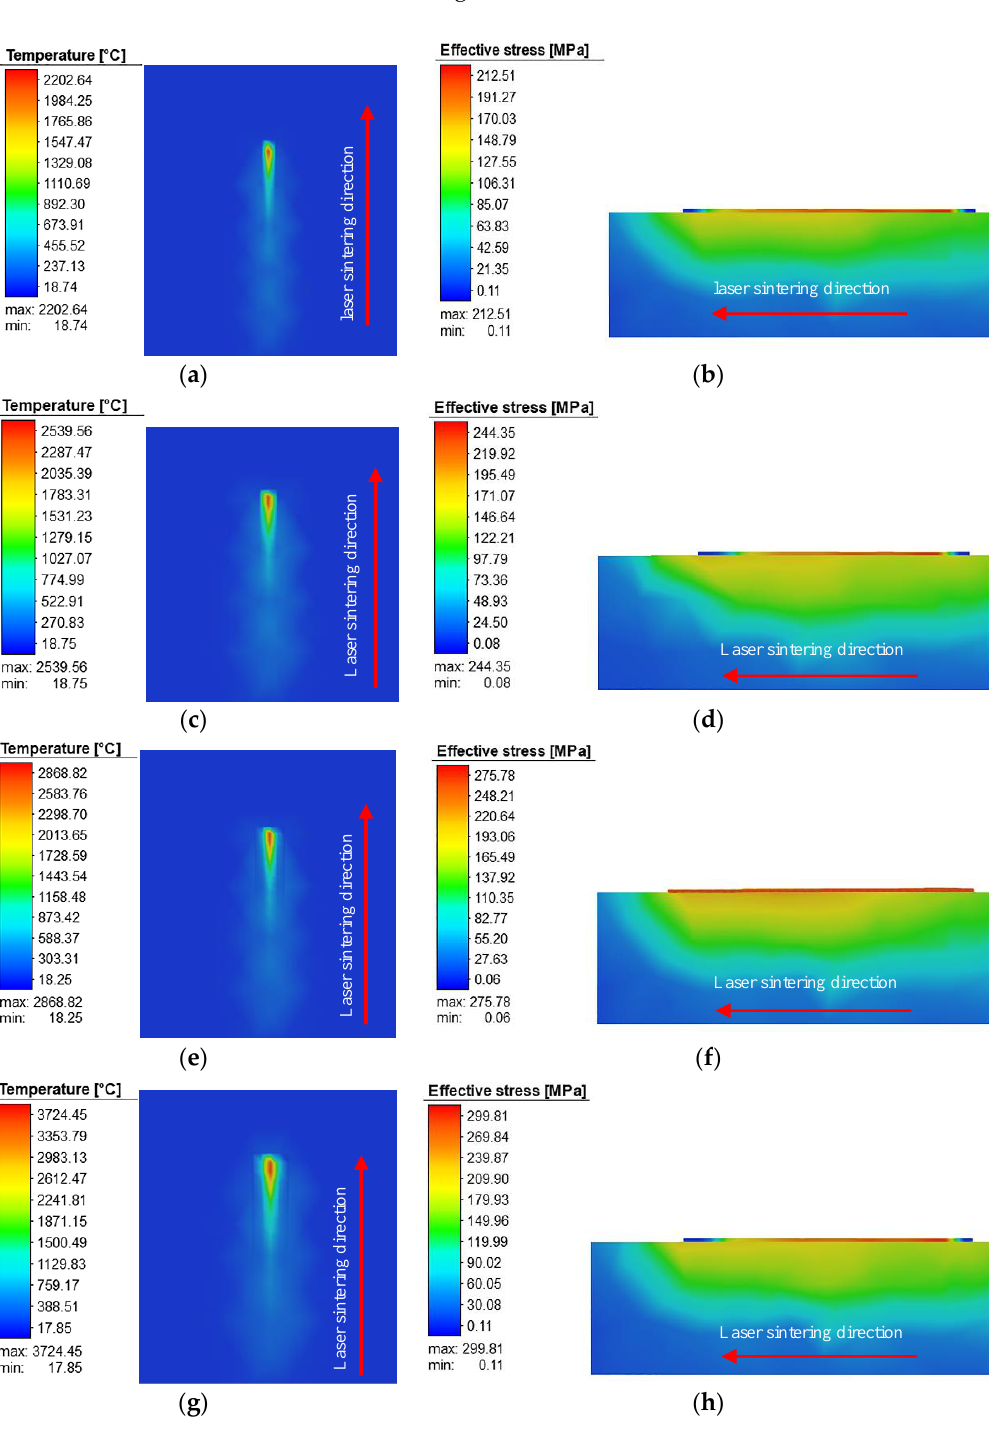
Figure 7. Temperature and stress fields in the melt pool for different energy densities: ( a , b ) ω = 41.7 J/mm 3 , ( c , d ) ω = 67.7 J/mm 3 , ( e , f ) ω = 77.4 J/mm 3 , and ( g , h ) ω = 111.1 J/mm 3 . From the temperature field (a), (c), (e), and (g) plots in Figure 7, it is seen that the laser shows a predominantly comet-like path during processing, with a significantly higher temperature gradient in front of the heat source than at the tail. The most important factor influencing the difference in the melt pool morphology and temperature is the ab- sorption ratio of the laser. Mahyar et al. [18] demonstrated that the absorption ratio of the laser is an important parameter to consider when studying the melt pool and related phe- nomena. Figure 7 shows the simulated analysis of the SLM process for layer 1. As seen in